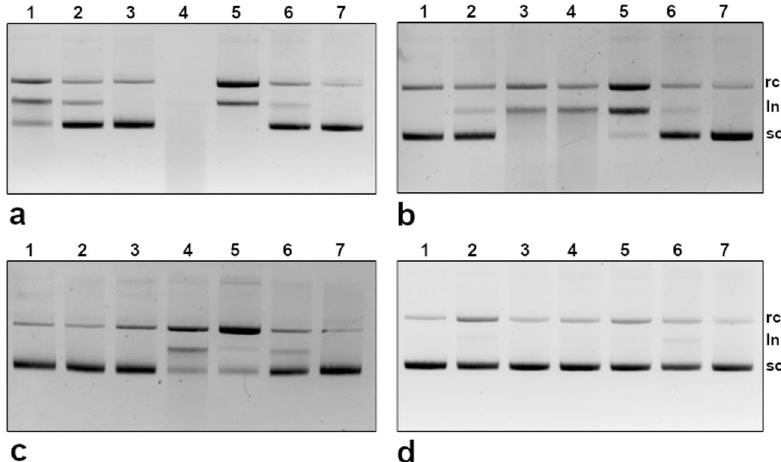
Fig. 3 DNA hydrolysis by total IgG antibody. a – d Neuropsychiatric systemic lupus erythematosus (NP-SLE), schizophrenia (SCZ), bipolar disorder (BPD), and healthy control (HC) samples, respectively. Plasmid DNA, pUC18 (50ng) was incubated with IgG (2µg) for 2h at 37°C and visualised by ethidium bromide stain. Lanes: 1 – 5, IgG from patients; 6, IVIg & 7, DNA incubated alone. sc supercoiled DNA, rc relaxed circular DNA, ln linear